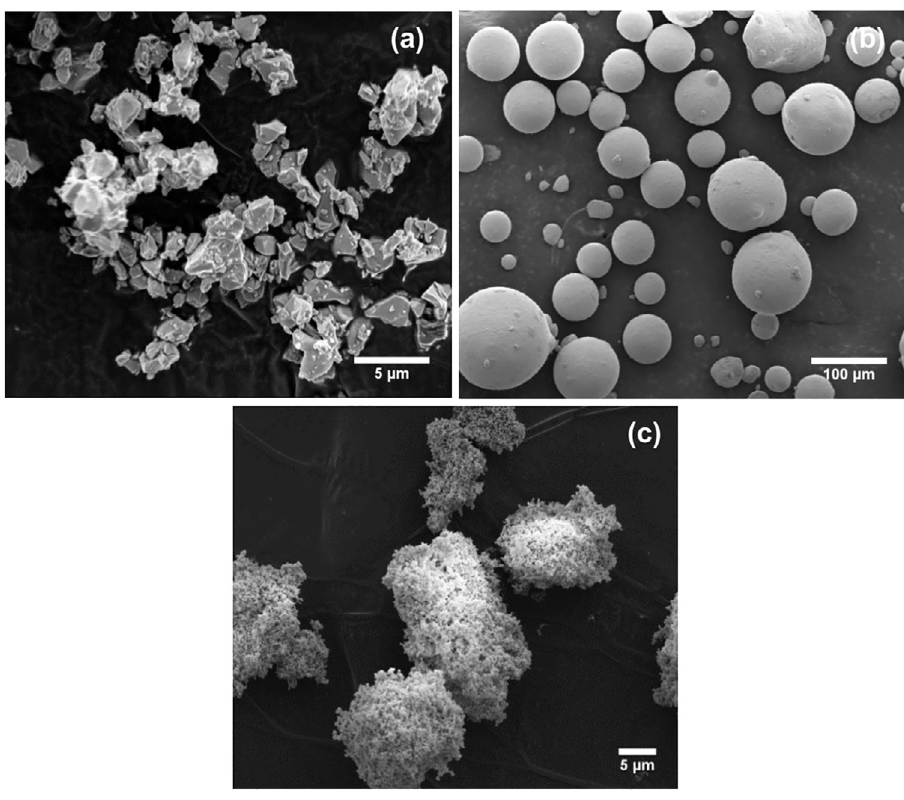
Figure 2. FEG-SEM micrographs of (a) LSGM, (b) 8YSZ and (c) 20 wt.% 8YSZ added to LSGM.